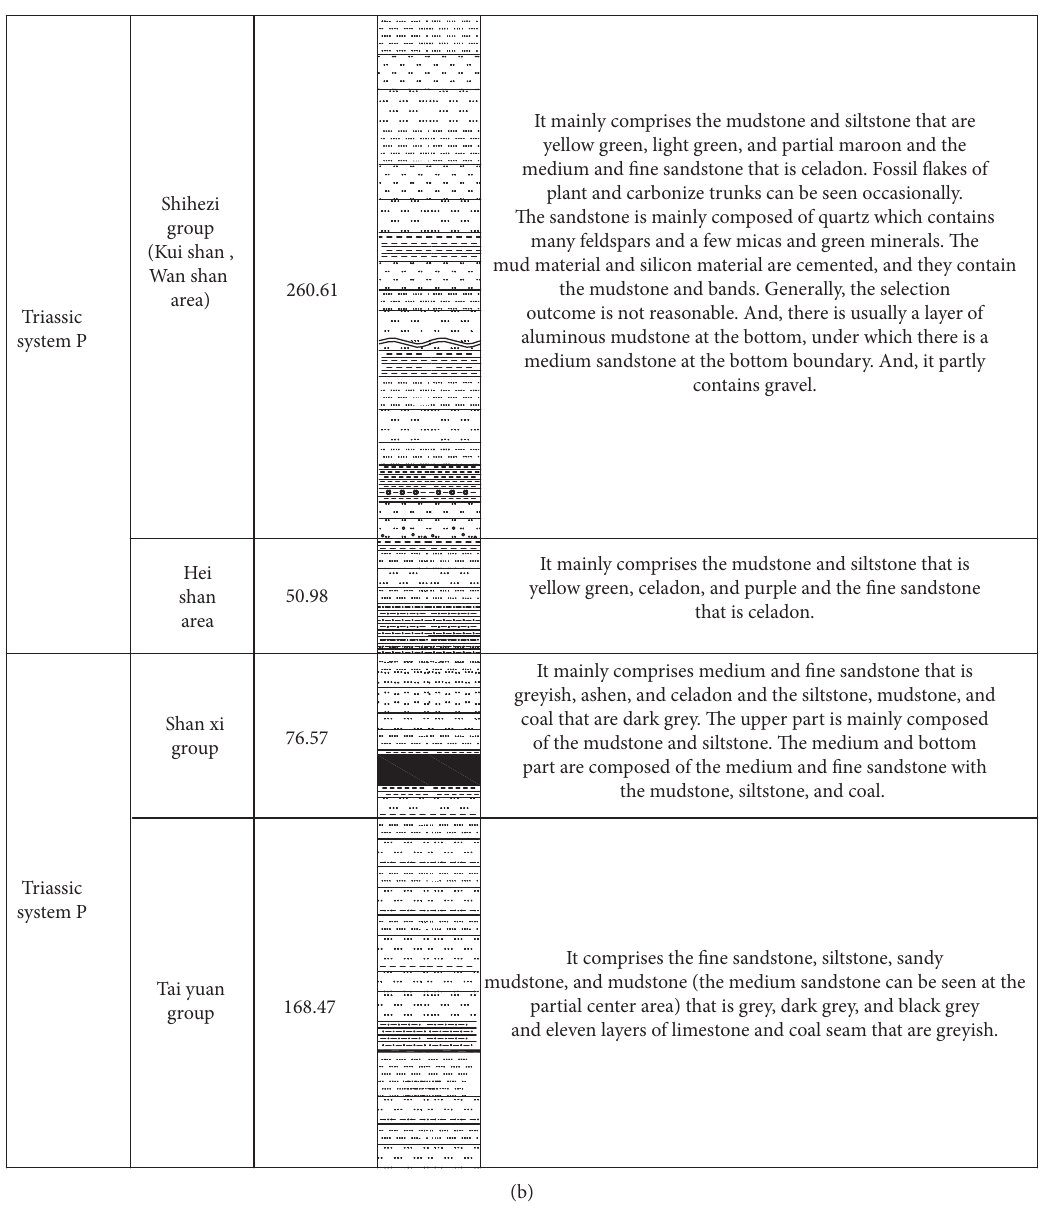
Figure 1: Stratigraphic distribution of the